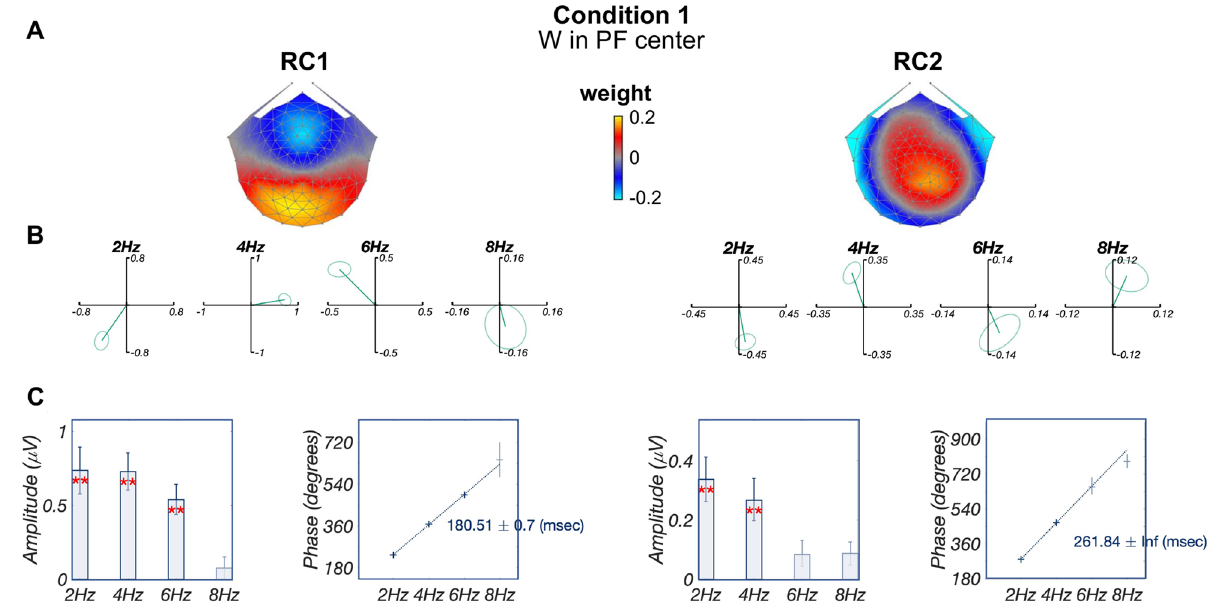
Figure 3. Deviant analysis: visual word form processing. ( A ) Topographic visualizations of the spatial filters for the first two components (RC1 and RC2); ( B ) Response data in the complex plane, where amplitude information is represented as the length of the vectors, and phase information in the angle of the vector relative to 0 radians (counterclockwise from 3 o’clock direction); ellipse indicates standard error of the mean for both amplitude and phase; ( C ) Projected amplitude (left) for each harmonic in bar charts, ** p FDR < 0.01 , as well as latency estimations (right) across significant harmonics. Figures were created using publicly available MATLAB (R2020a) code: https:// github. com/ svndl/ rcaEx